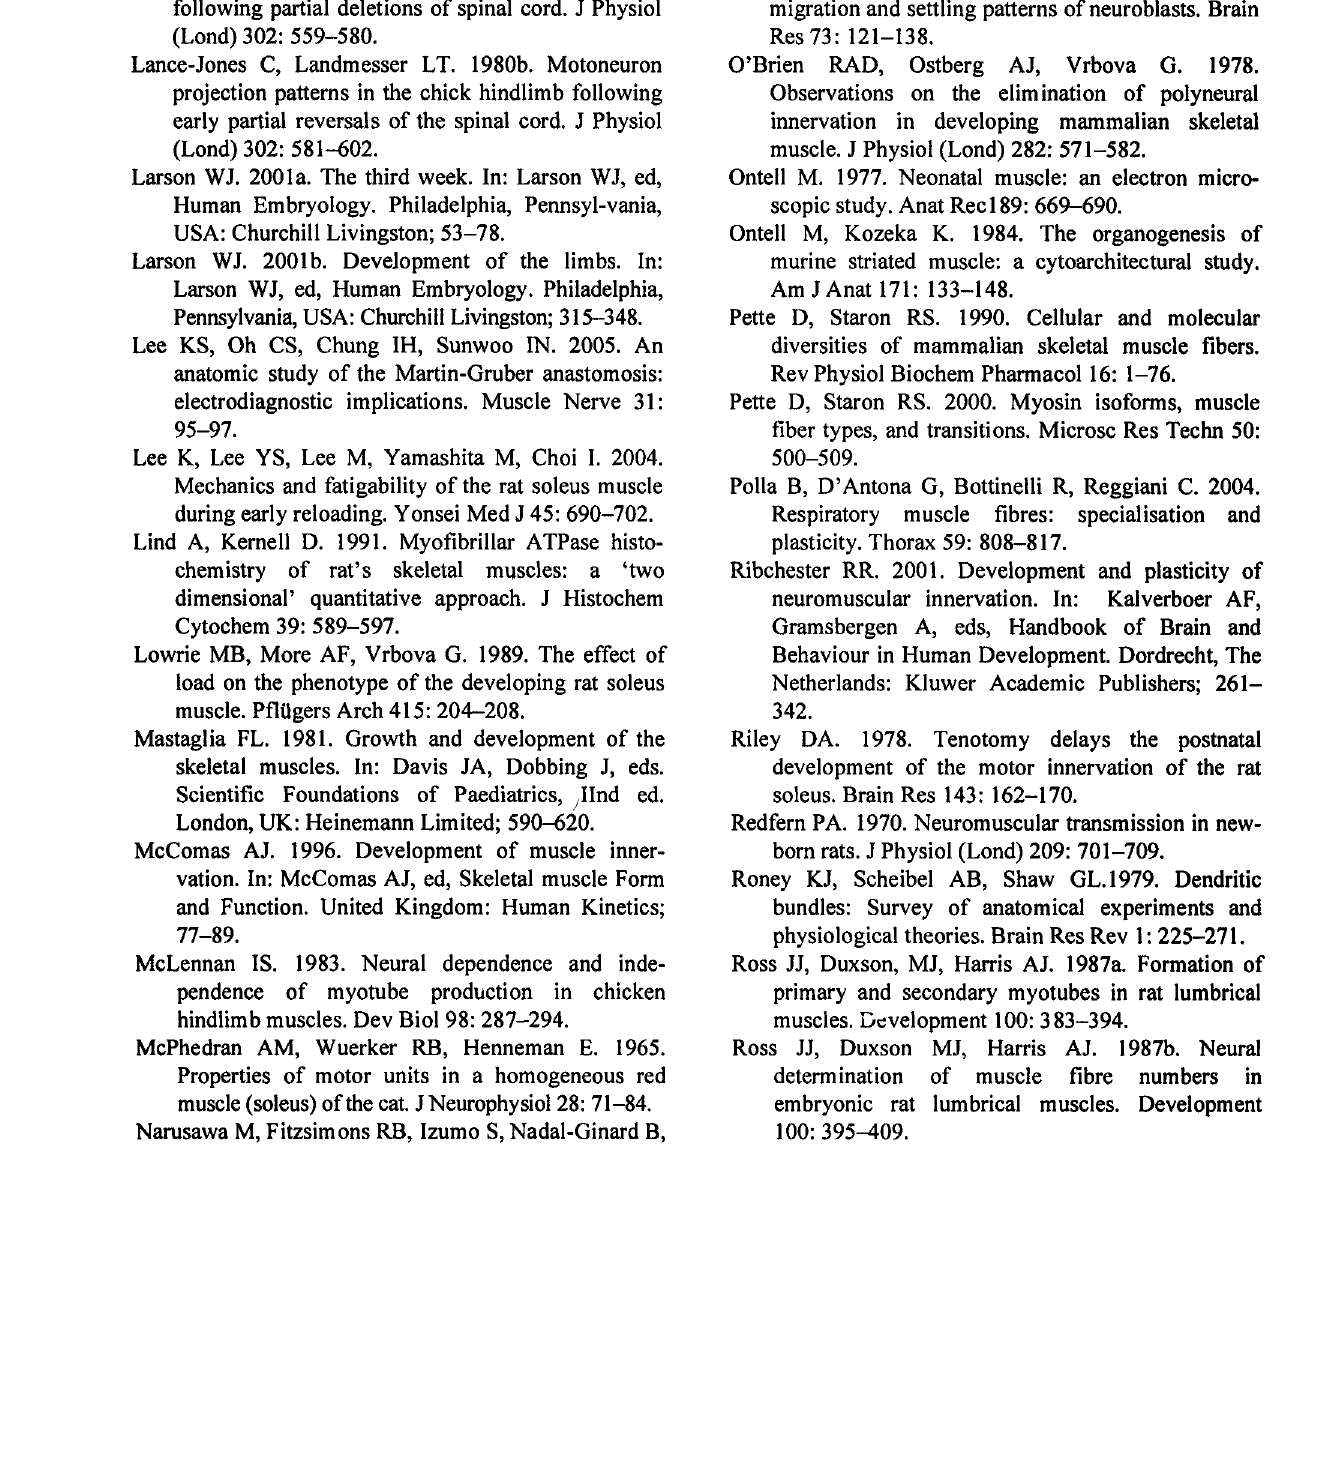
embryonic rat lumbrical muscles.